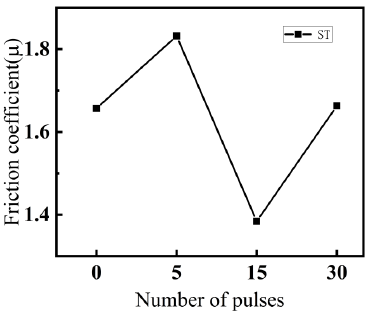
Figure 8: The change of friction coeflcient for Zr-17Nb alloy surface before and after HCPEB modification